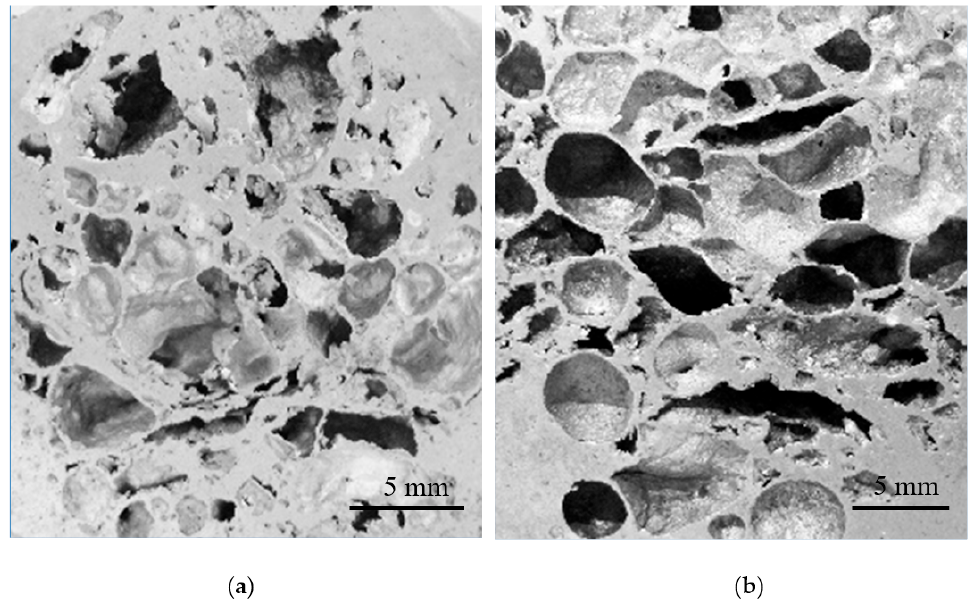
Figure 8. Macrostructures of Al–15Ni foams with 5 wt.% ( a ) and 7 wt.% ( b ) dolomite additions.